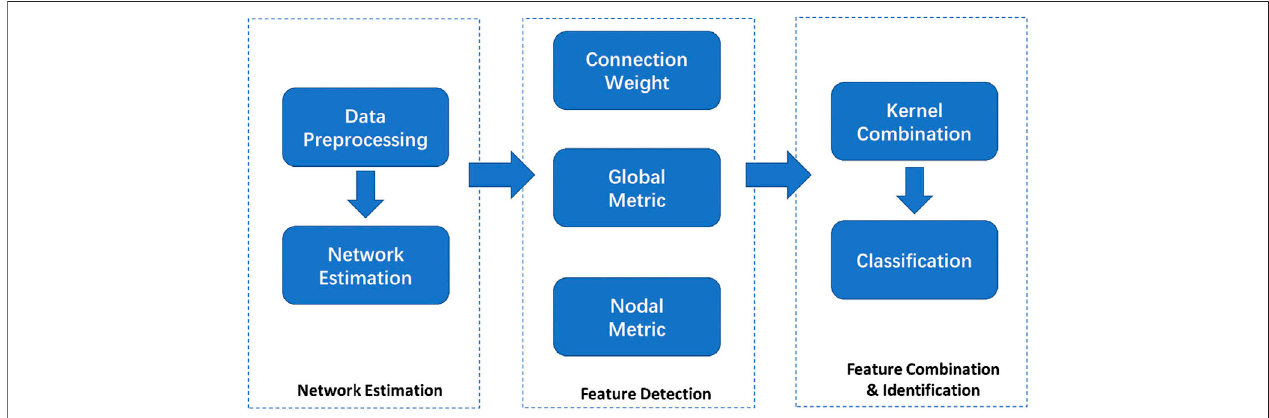
FIGURE 1 | Data-processing and classi fi cation procedures employed in our study. Network Estimation: Positron emission tomography (PET) with 18 F- fl uorodeoxyglucose (FDG) imaging of patients were enrolled. Individual FDG-PET image volumes were spatially normalized into standard stereotactic Montreal Neurological Institute (MNI) space with linear and nonlinear 3D transformations using statistical parametric mapping software on MATLAB. Individual ’ s metabolic brain network was ascertained using the proposed Jensen-Shannon divergence similarity estimation (JSSE) method. Feature Detection: Based on binary undirected matrices, we systematically analyzed the functional brain network ’ s global and local properties with the Graph Theoretical Network Analysis Toolbox. Also, the nodal properties included degree centrality, nodal ef fi ciency, betweenness centrality, shortest path length, and nodal clustering coef fi cient. We then took the sum of49 values foreachnodeasinputfortheattributestotraintheclassi fi er,sotherewasonlyonevaluecorrespondingtoonegraphmetric.FeatureCombinationandIdenti fi cation:We compared the similarity and difference in the JSSE network and its topological measurements between the seizure recurrence and seizure free groups. The two groups were then classi fi ed by combining the information from connection and topological metrics, which was conducted by the multiple kernel support vector machine. The validation was performed using the nested leave-one-out cross-validation strategy to con fi rm the performance of the methods.